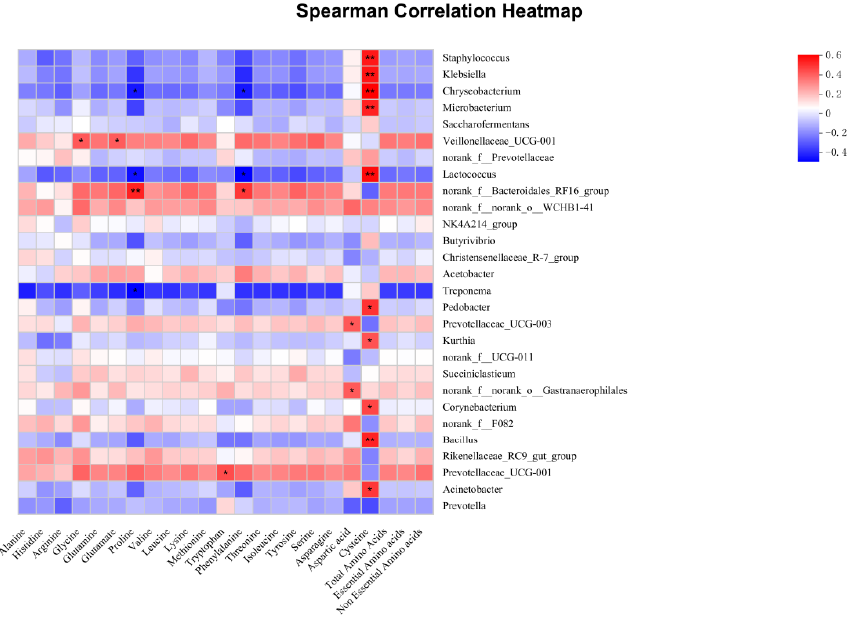
Figure 6. Correlation analyses between the amino acid contents and top 28 rumen bacterial genera. In the two-dimensional heat map, the change in defined color and its depth indicates the nature and strength of the correlation, respectively. An asterisk sign was used when the r value was greater than 0.1 and the p values were less than 0.05 (* p < 0.05, ** p < 0.01). 0.1 and the p values were less than 0.05 (* p < 0.05, ** p <